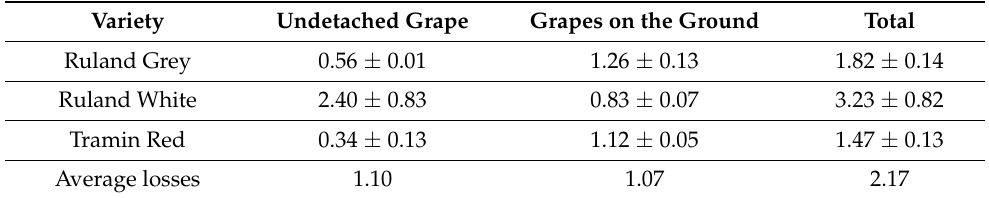
Table 6. Harvest losses, % of production, cv. Ruland Grey, Ruland White, and Tramin Red (2018). Variety Undetached Grape Grapes on the Ground Total Ruland